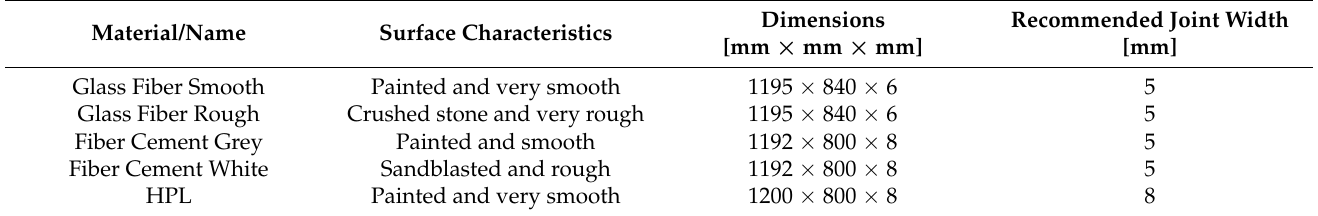
Table 3. Overview of different panels used in laboratory measurements and the supplier’s rec- ommended joint widths (without protection measures) (fourth column), referred to as “standard recommendations” throughout this article.